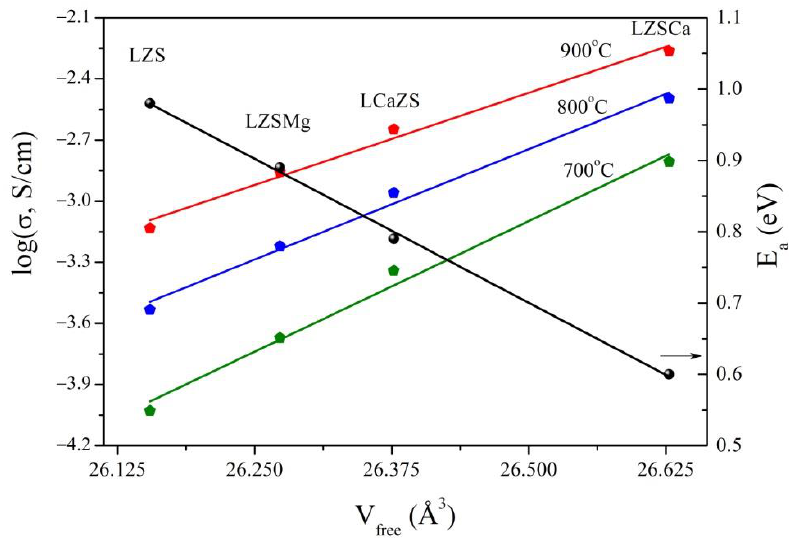
Figure 8. Comparison of the conductivities and activation energies as a function of the free lattice volume for high-temperature region (T > 700 °C) in dry air for the samples: La 2 ScZnO 5.5 (LSZ), La 2 Sc 0.9 Mg 0.1 ZnO 5.45 (LZSMg), La 2 Sc 0.9 Ca 0.1 ZnO 5.45 (LZSCa), and La 1.9 Ca 0.1 ScZnO 5.45 (LCaZS).